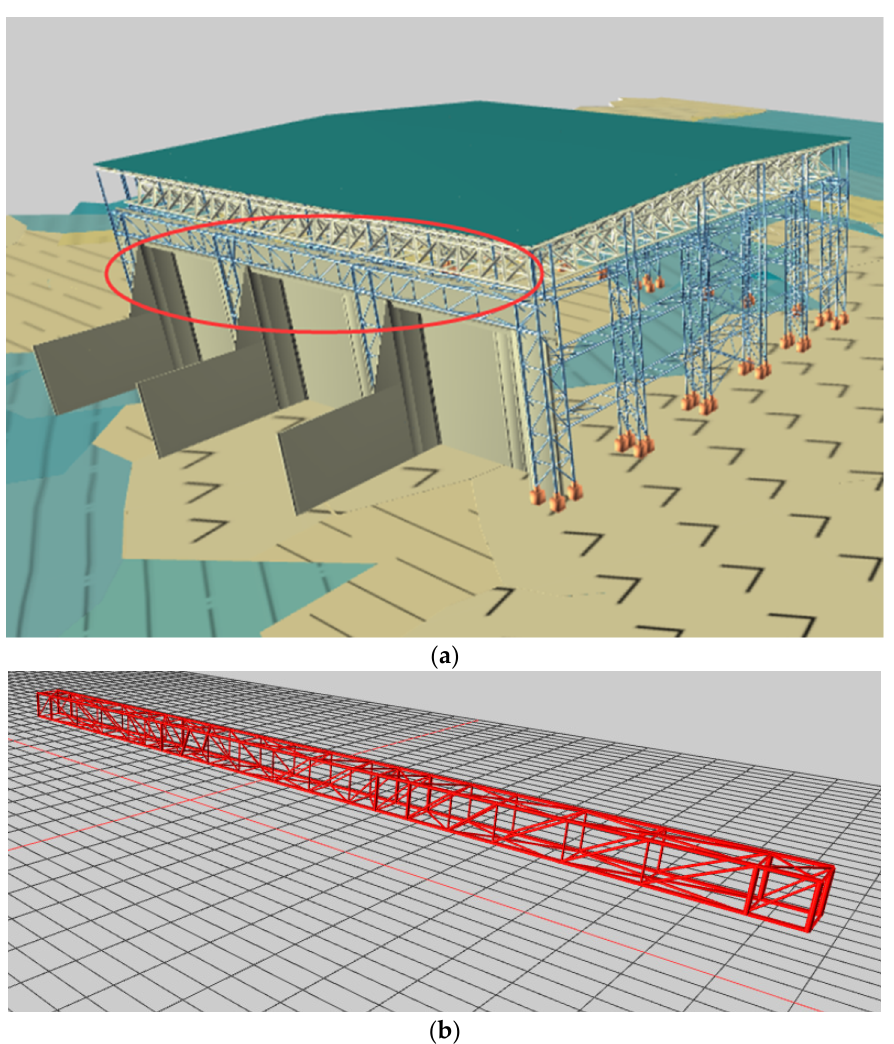
Figure 21. Selection of structural members for the long − span converter station steel structure. Any node can be selected to check the stress and deflection of the long-span converter station steel structure, as shown in Figure 22.